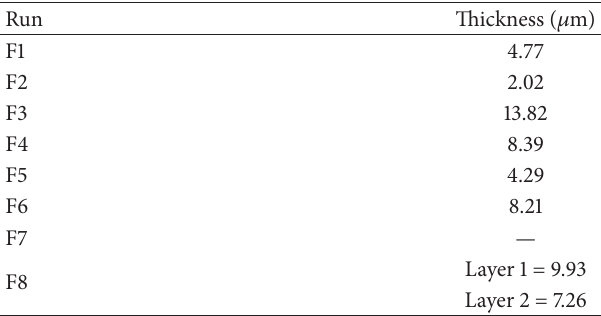
Table 2: Average thickness of TiO experimental design.